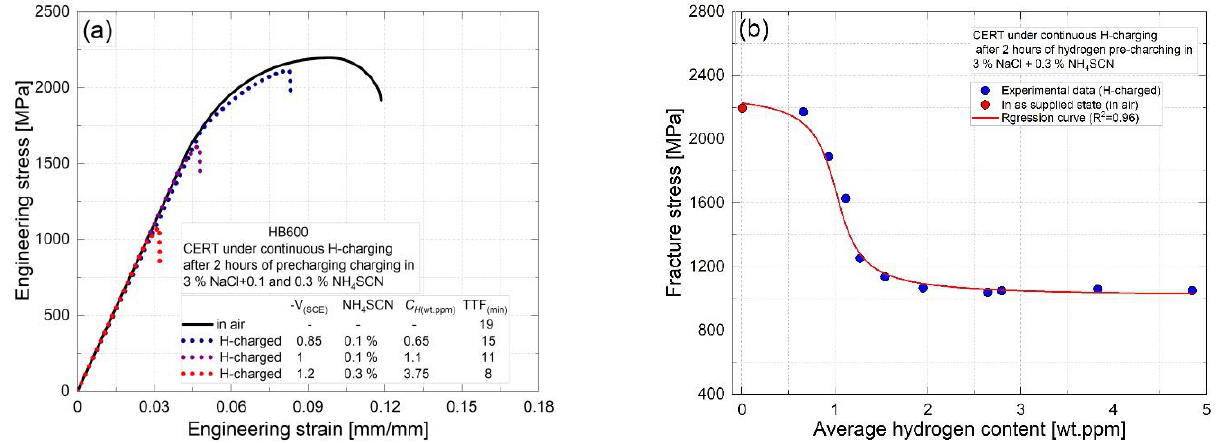
Figure 5. ( a ) Engineering stress versus strain curves of studied steel showing the effect of hydrogen on the tensile property of studied steel; ( b ) hydrogen embrittlement curve of tested steel showing a clear lower plateau at 1100 MPa.